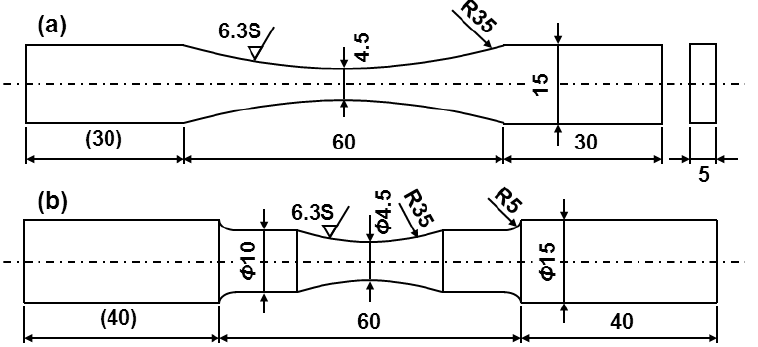
Figure 2. Dimensions of notch fatigue test specimens. ( a ) Notch plate specimen (K ( b ) R-notched ( K = 1.5, 2.0, 2.5, and 3.0); and ( c ) V-notched ( K t